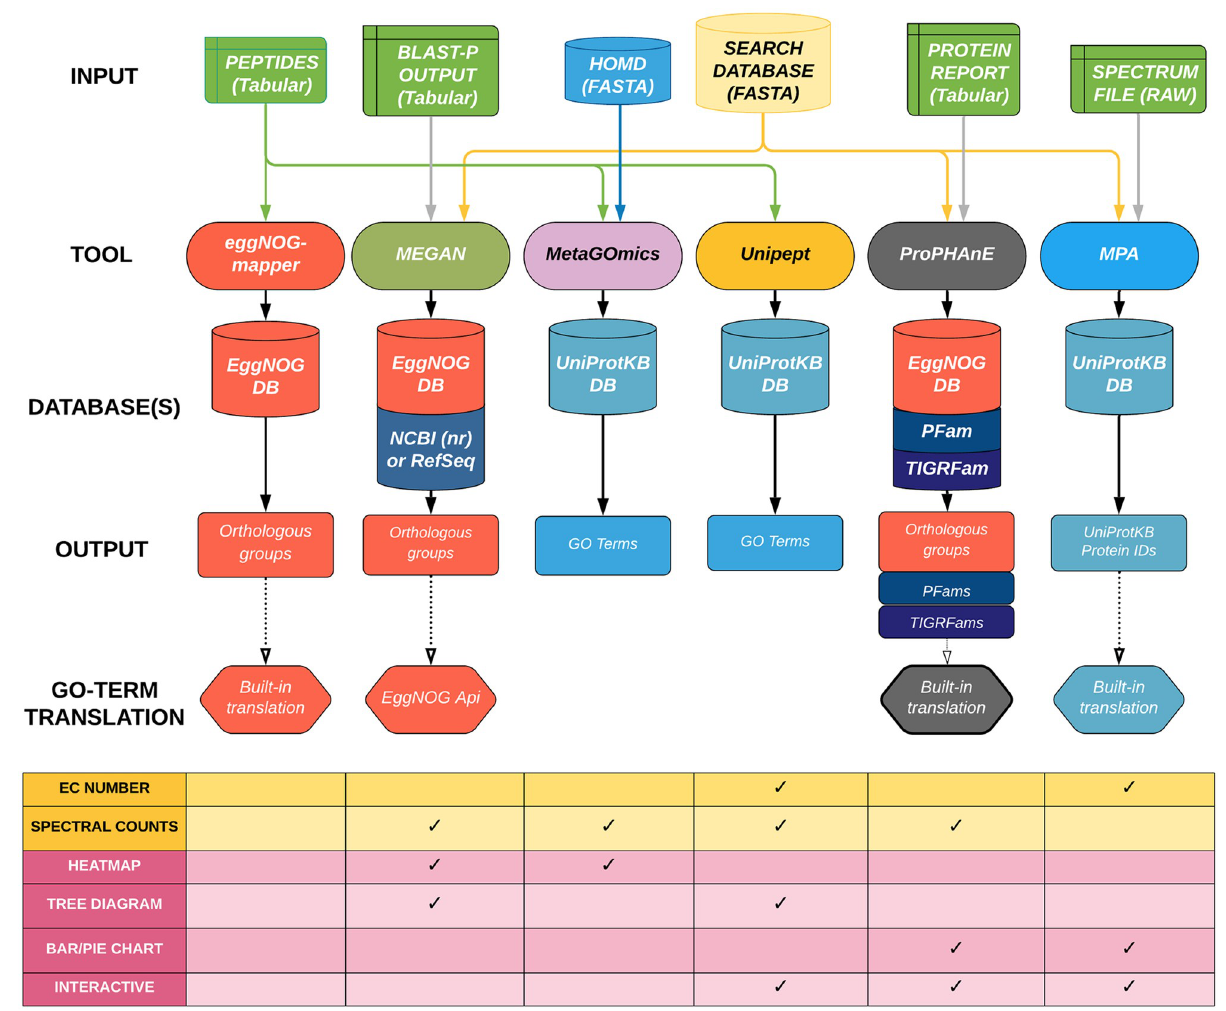
Fig 1. A comparative workflow of all six functional software tools producing GO term lists from the same dataset. The inputs that are required for each software tool are connected from the top. The reference databases used for each tool are aligned in the middle. The outputs and Gene Ontology (GO) term translation processes are outlined at the bottom. Additional output types (data and visualizations) are shown in the table underneath the